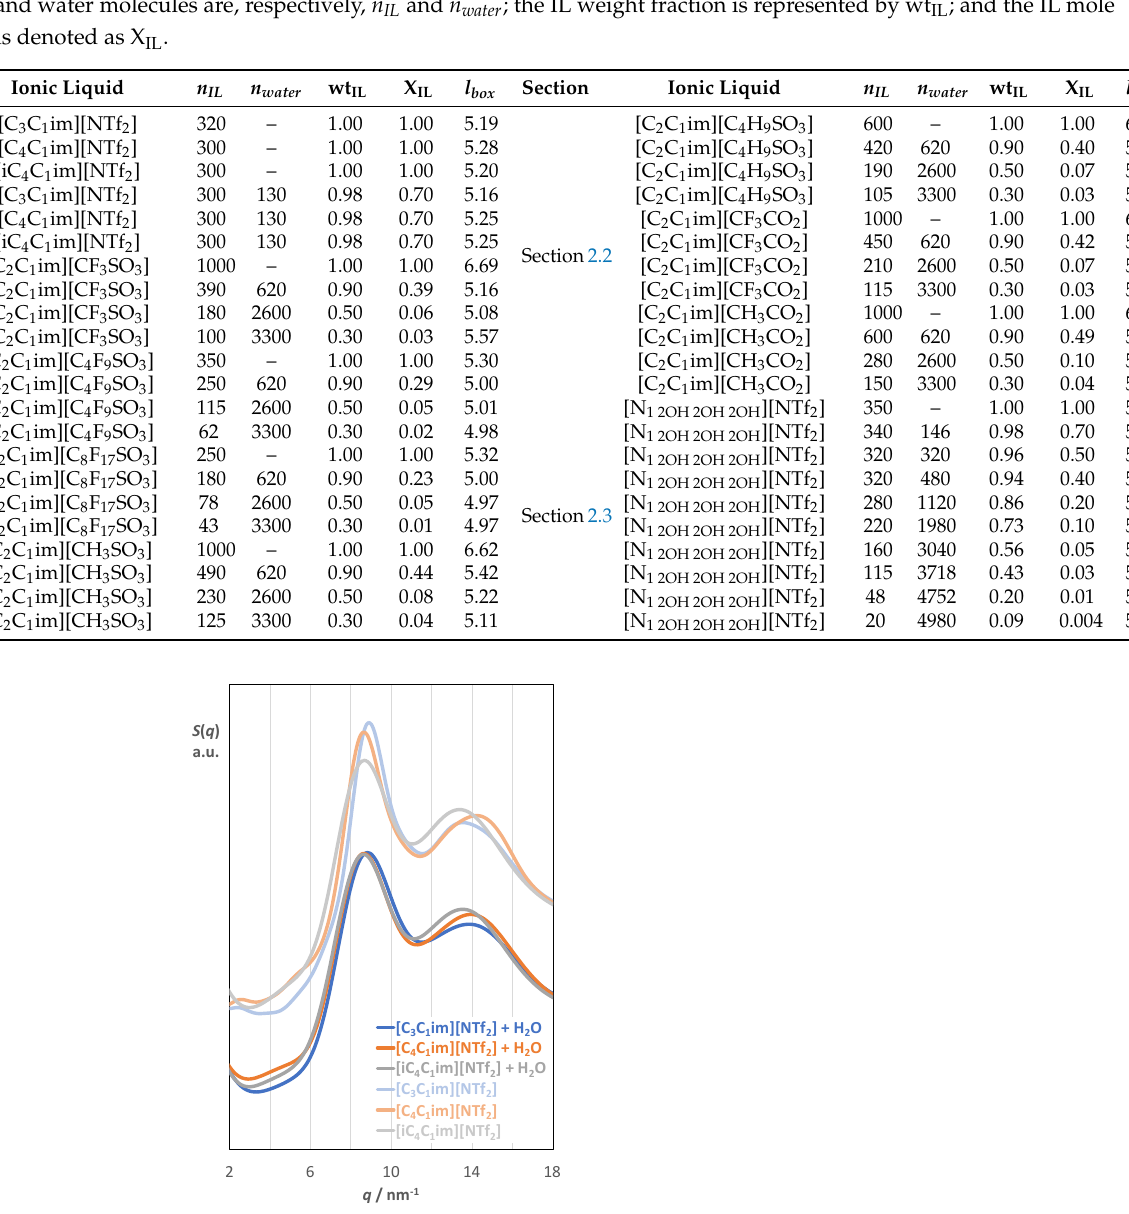
Figure 1. Structure factor functions, S ( q ), calculated at 320 K for pure [C 3 C 1 im][NTf 2 ], [C 4 C 1 im][NTf 2 ], and [iC 4 C 1 im][NTf 2 ] ILs and its aqueous solutions with X IL = 0.70 (wt IL = 98%). There is a small shoulder at approximately 4 nm − 1 for [C 4 C 1 im][NTf 2 ], both in the pure IL and in the aqueous solution. This corresponds to the emergence of a PNPP (polar– nonpolar peak) that reflects characteristic distances between strands of the polar network separated by the (nonpolar) alkyl moieties of the cations. The shoulder is more subdued for [iC 4 C 1 im][NTf 2 ] and suppressed for [C 3 C 1 im][NTf 2 ]. PNPPs are known to occur